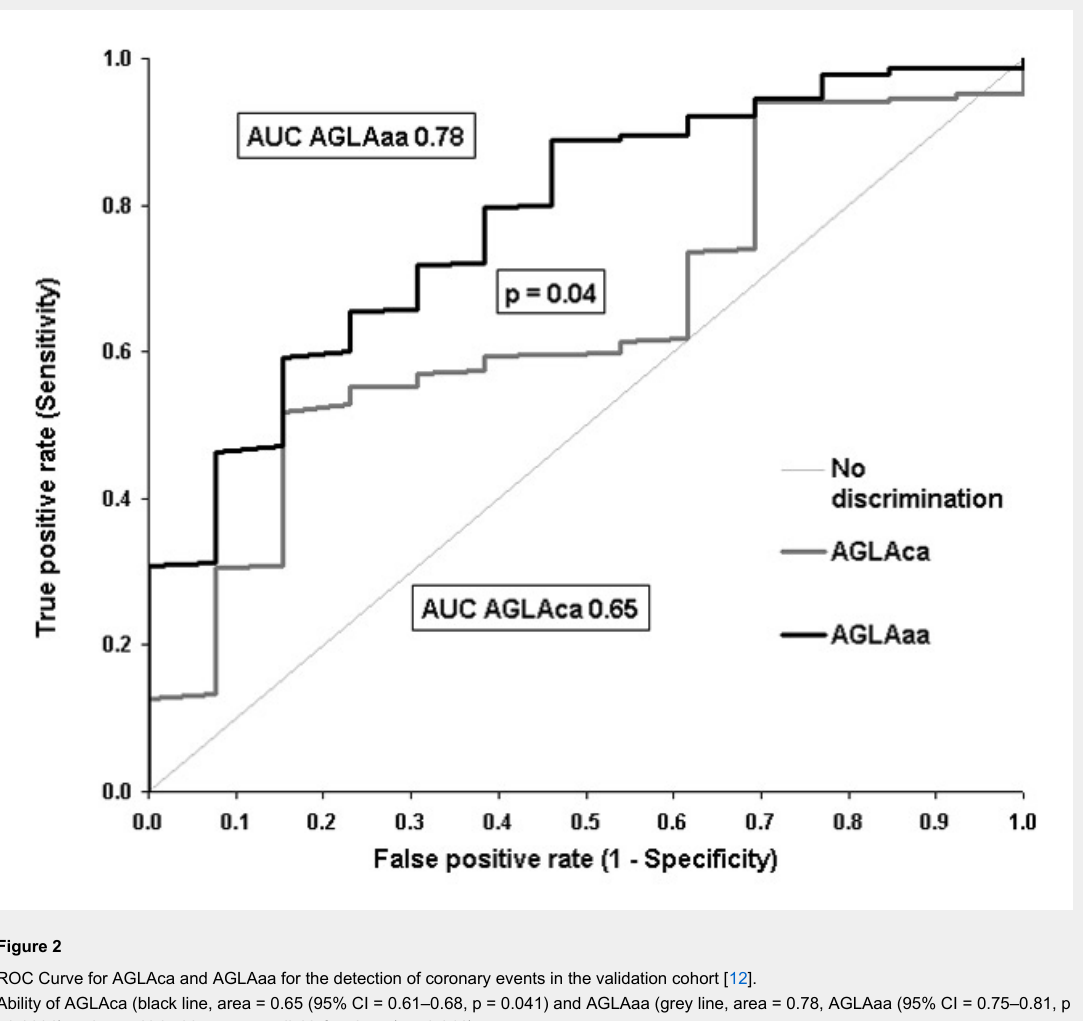
Figure 2 ROC Curve for AGLAca and AGLAaa for the detection of coronary events in the validation cohort [12]. Ability of AGLAca (black line, area = 0.65 (95% CI = 0.61–0.68, p = 0.041) and AGLAaa (grey line, area = 0.78, AGLAaa (95% CI = 0.75–0.81, p <0.0001) to detect 13 incident myocardial infarctions (p = 0.041). aa = arterial age; AGLA = Arbeitsgruppe Lipide und Atherosklerose (Swiss coronary risk calculator); AUC = area under the curve; ca = chronological age; CI = confidence interval; ROC = receiver operator